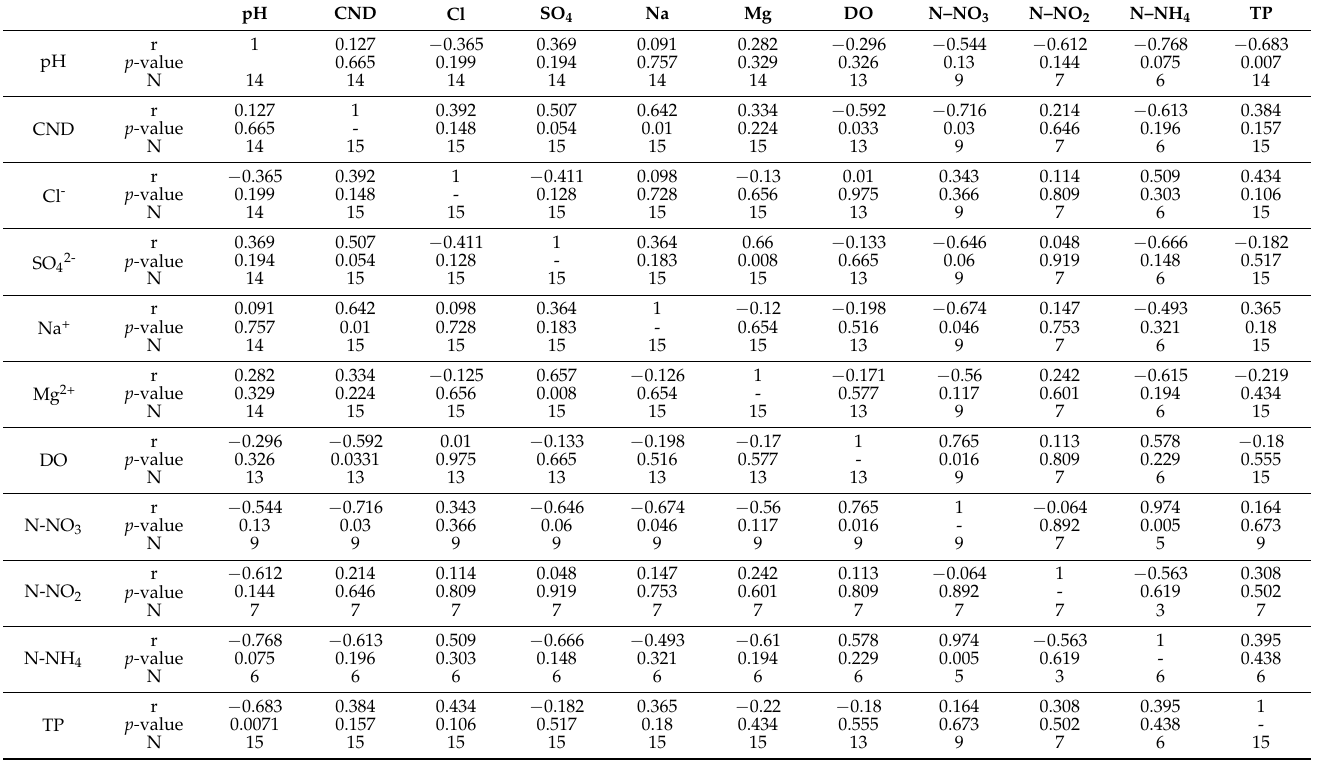
Table 2. Correlation coefficients and p -values of the studied water quality parameters for the wet period 1983–1997.